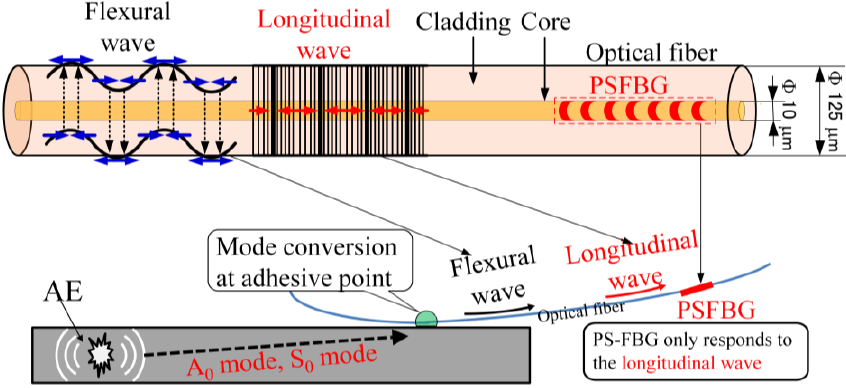
Figure 2. Detection mechanism of PS-FBG sensor in the ADRM configuration.